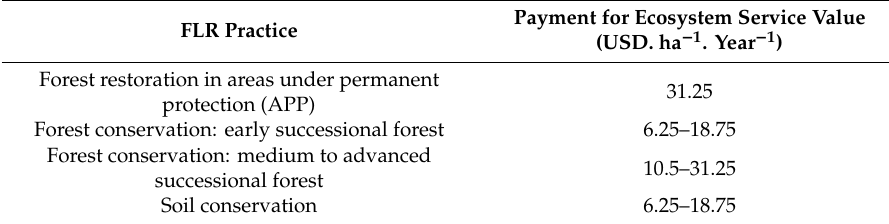
Table 1. Values assigned for payment for ecosystem services payments to landowners for forest and landscape restoration practices in the Water Producer Project in the Piracicaba, Capivari, and Jundiai watershed, Atlantic Forest, Brazil. Variation within forest conservation was related to the percentage of riparian permanently protected area that was forested or was delivered for restoration in the property, while for soil conservation the variation was based on soil erosion abatement (%) provided by the adopted practice. 1 USD = BRL 4 (November,